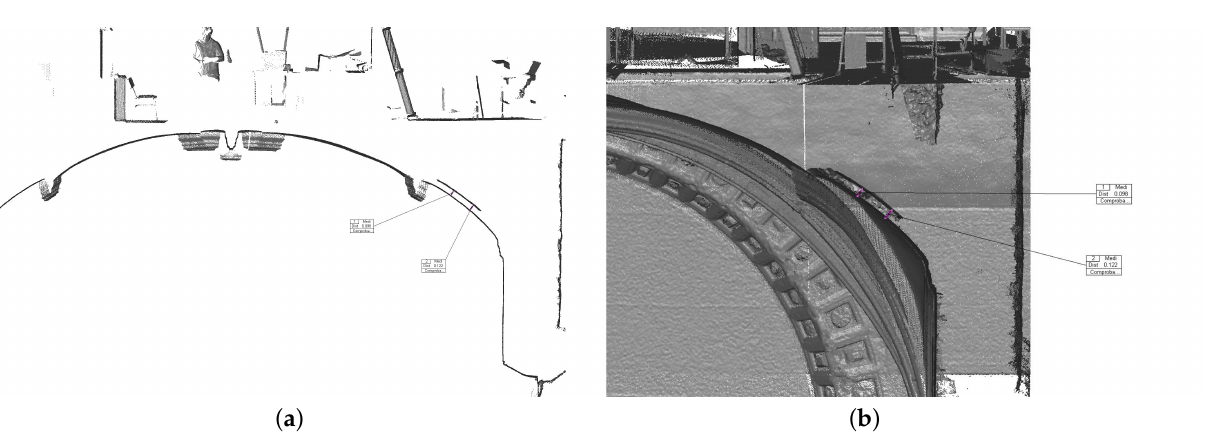
Figure 16. Point cloud section during the restoration works. ( a ) The measure of the vault section can be obtained. ( b ) In